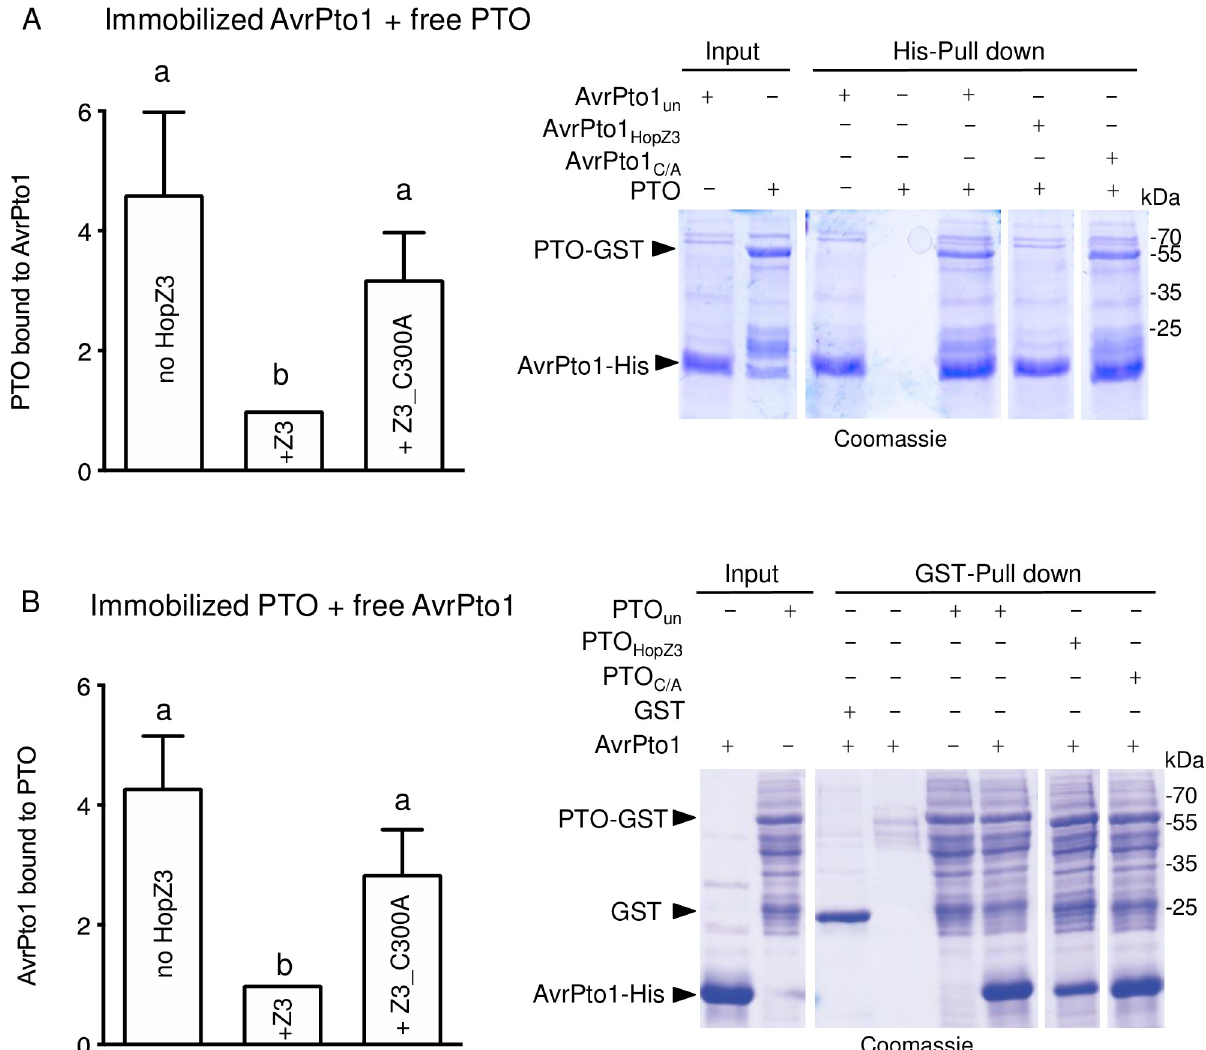
Fig 6. Effect of acetylation on AvrPto1 -PTO binding. (A) Acetylation of AvrPto1 reduces its interaction with PTO. Beads with immobilized Psy Psy His-AvrPto1 Psy were incubated for 2 h with acetyl-CoA, IP6 and HopZ3, HopZ3_C300A (C/A), or no HopZ3 (un, untreated). Beads were washed and then incubated with soluble unmodified PTO-GST for 1 h, and after washing and elution, proteins were resolved by SDS-PAGE and stained with Coomassie blue or silver. The last two lanes in gel images are from different gels run at the same time as the other lanes, and interaction was always quantified relative to immobilized protein in the same lane. The mean with the standard error of relative band intensities from at least four experiments is shown, with binding after reaction with HopZ3 set to 1. Different letters indicate significant differences (ANOVA/Fisher’s test P < 0.05). Bars indicate standard errors. (B) Acetylation of PTO reduces its binding to AvrPto1 Psy . Experiments with immobilized acetylated PTO-GST and free AvrPto1 -His were done as in Psy